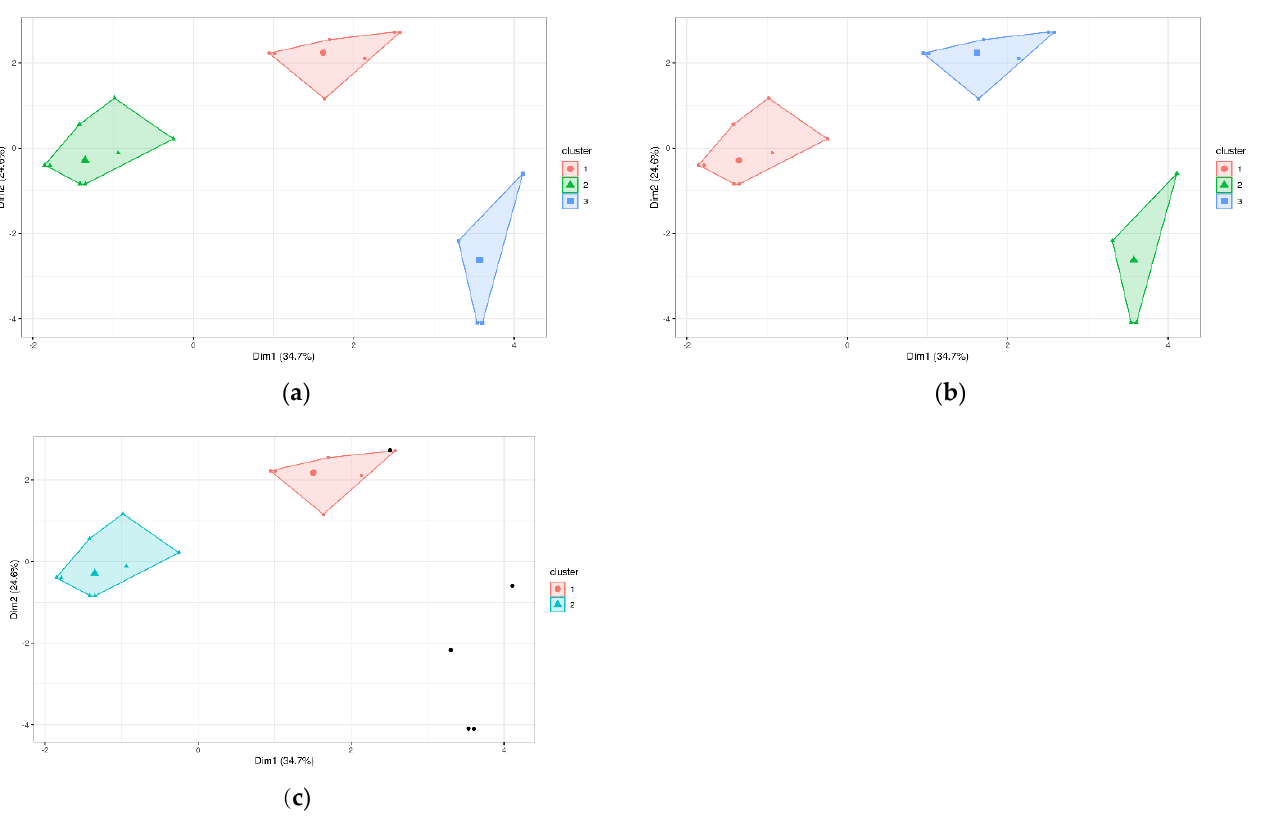
Figure 8. ( a ) Clustering with the k- means ++ algorithm; ( b ) clustering with the fuzzy means algorithm; ( c ) clustering with the DBSCAN